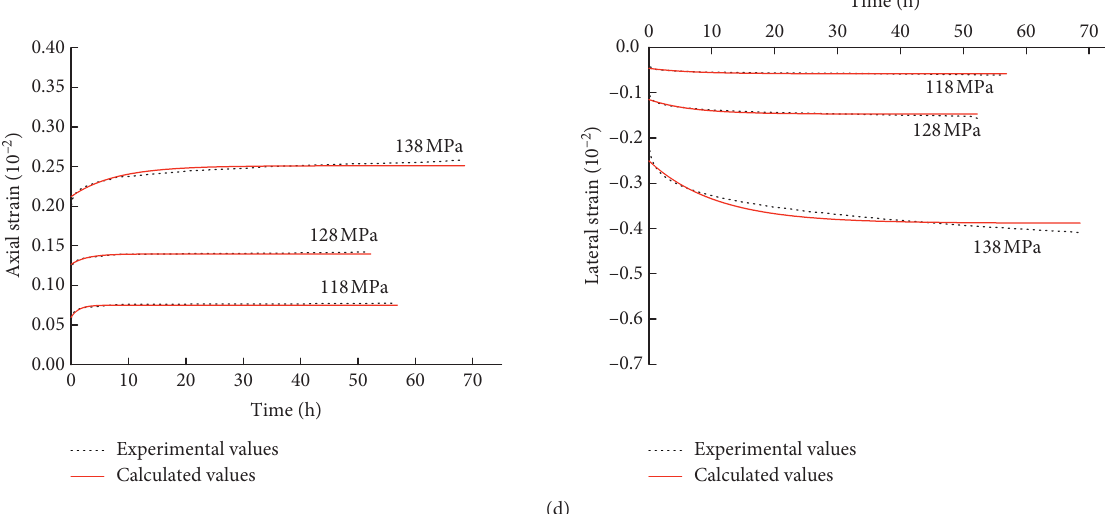
Figure 5: Relationships between the experimental and the calculated values at the low stress level. (a) 0 th cycle. (b) 2 nd cycle. (c) 6 th cycle. (d) 10 th